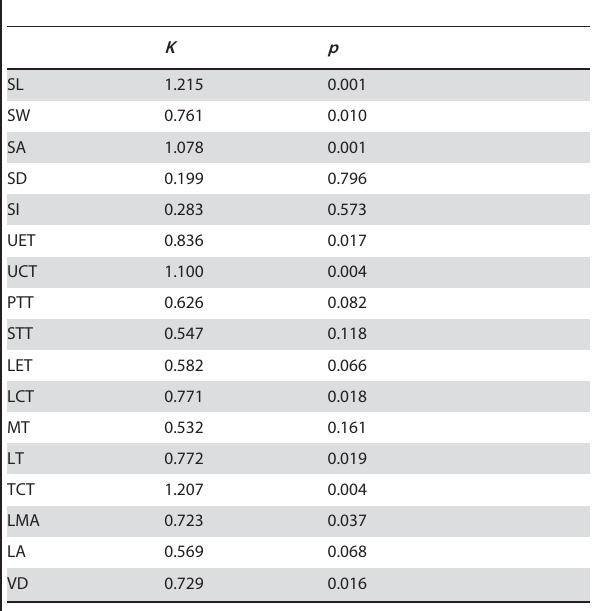
Table 3. Phylogenetic signal ( K ) of leaf attributes and stomatal traits in 17 Paphiopedilum species.